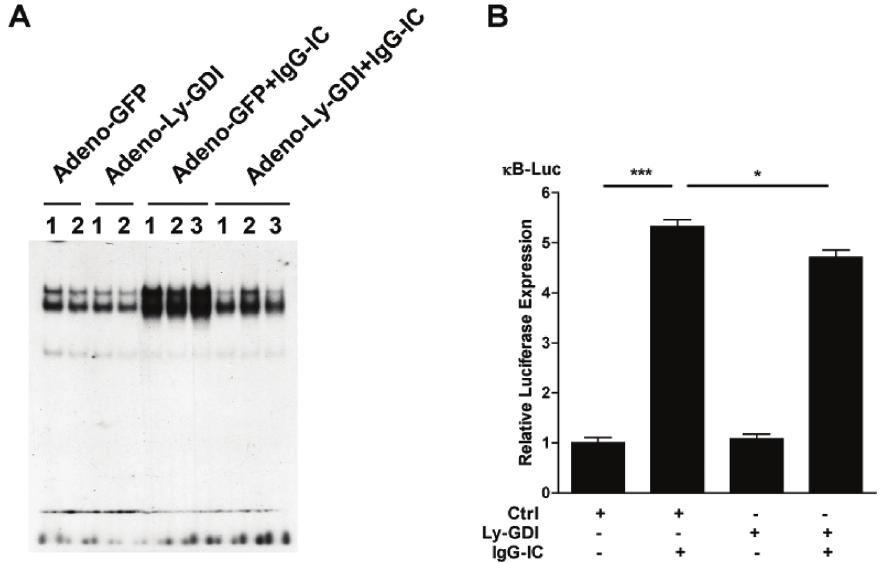
Fig 7. Ly-GDI inhibits IgG immune complex-induced NF- κ B activity in the lung and alveolar macrophages. (A) Adeno-GFP or Adeno-Ly-GDI was injected to mice via an airway instillation at a dose of 5 × 10 8 PFU. 3 days later, the mice were subjected to IgG immune complex-induced lung injury or control treatment ( α BSA only). Lungs were harvested 4 h later. Whole lung nuclear proteins were extracted, and subjected to EMSA to determine the NF- κ B DNA binding activity. (B) MH-S cells were transiently transfected with indicated genes. 48 h later, the cells were treated with or without 100 μ g/ml IgG immune complexes for 4 h. The cell lysates were used to evaluate luciferase expression. Luminometer values were normalized for expression from a co-transfected thymidine kinase reporter gene. These values were then normalized to a relative value of 1 for the control plasmid transfected cells that did not receive IgG IC challenge. The data were expressed as means ± S. E. M. N = 3. * and *** indicated statistically significant difference- p < 0.05, and p < 0.001,